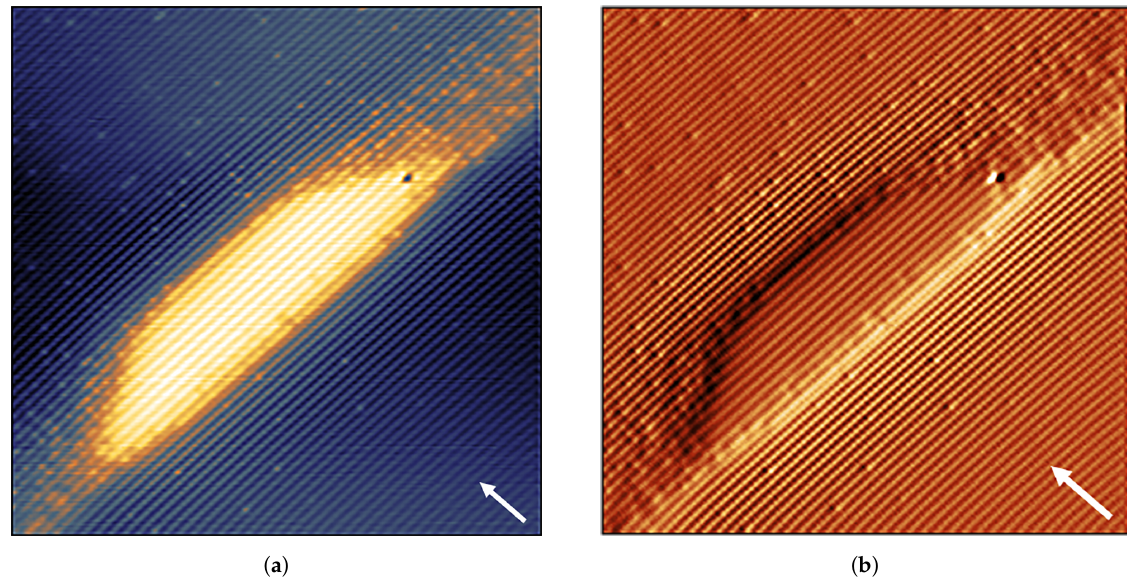
Figure 16. 30 × 30 nm 2 : ( a ) filled-state topographic image (dark to bright contrast represents a height difference of 338 pm); ( b ) current image (bright to dark contrast represents current difference of 40 pA); taken at V b = − 3 V, I t = 50 pA revealing the typical structure of the InAs/InP DEQDs. The arrow indicates the growth direction